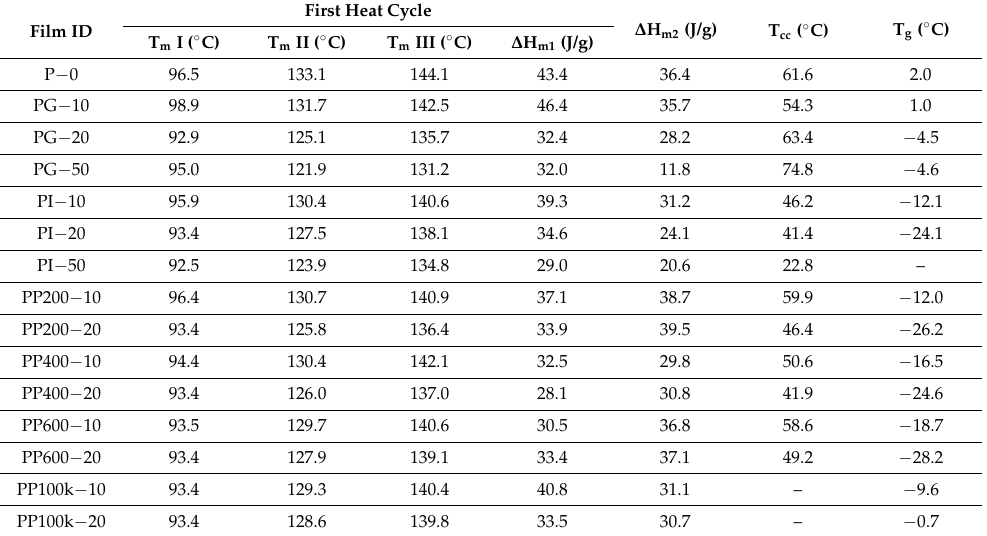
Table 3. DSC parameters of PHBH films: first (T m I), second (T m II), and third (T m III) melting temperature; melting enthalpies of the first ( ∆ H m1 ) and second ( ∆ H m2 ) heat cycles; cold crystallization temperature (T cc ); glass transition temperature (T g